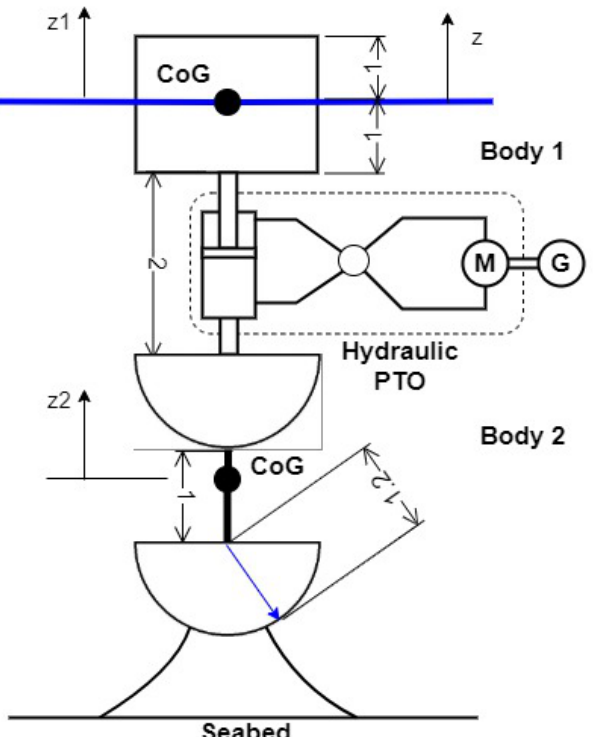
Fig. 1: The geometry of the two-body system.